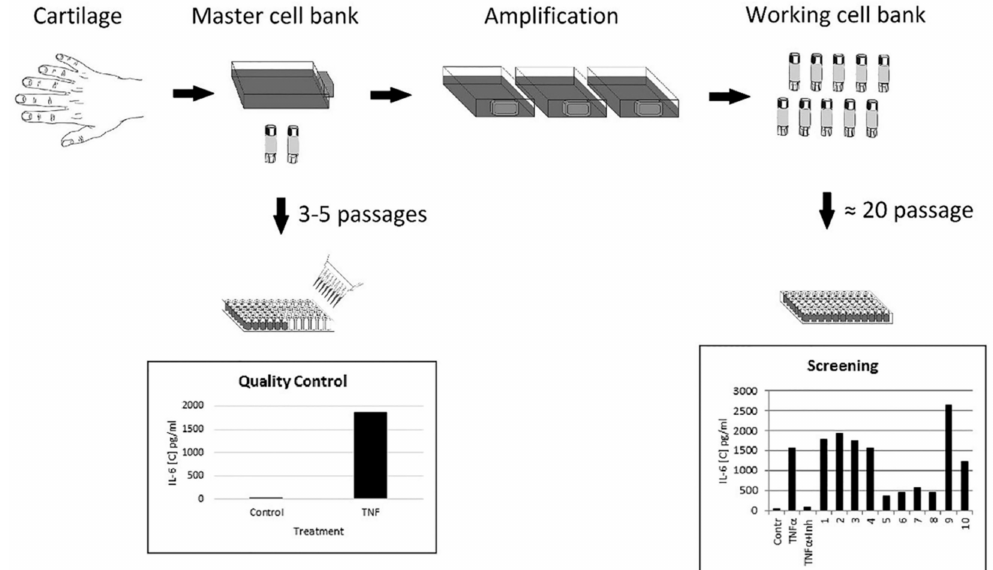
Figure 1. Design of the ready-to-use cell bioassay. Master and working cell banks could be obtained in advance of screening. Immature cartilaginous one-donor cells, which have been validated for quality (master cell bank), can be expanded and stored in liquid nitrogen (working cell bank) and then used routinely over extended periods of time for bioassays.